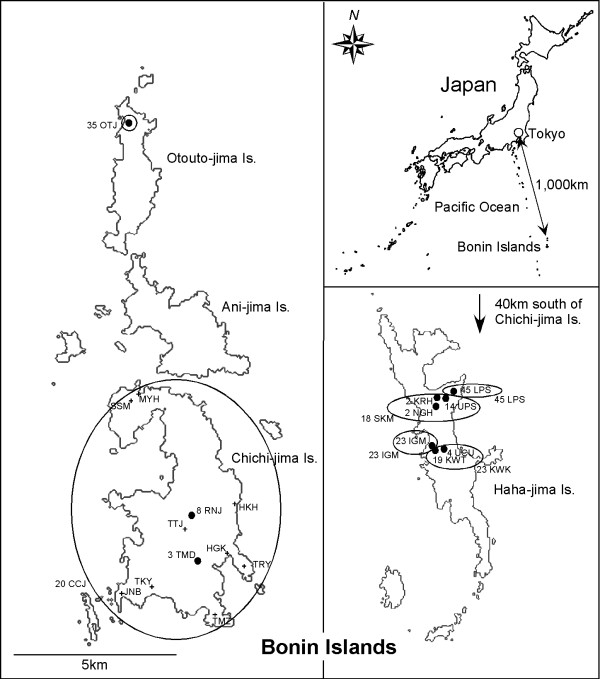
Location of the Bonin Islands and the location of each remnant tree of M. boninensis. The plus signs and black dots represent solitary trees and tree clumps, respectively. The number beside each black dot indicates the number of trees in that clump. The ellipses indicate the six operational populations.